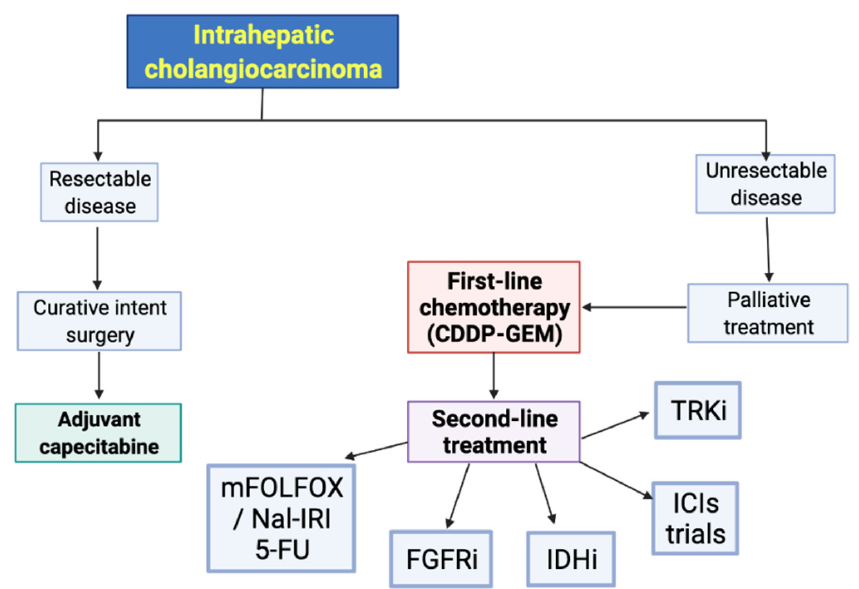
Figure 3. Proposed treatment algorithm for intrahepatic cholangiocarcinoma patients, according to available evidence. Abbreviations: CDDP: cisplatin; FGFR: Fibroblast Growth Factor Receptor inhibitors; GEM: gemcitabine; ICIs: immune checkpoint inhibitors; IDHi: Isocitrate Dehydrogenase inhibitors.